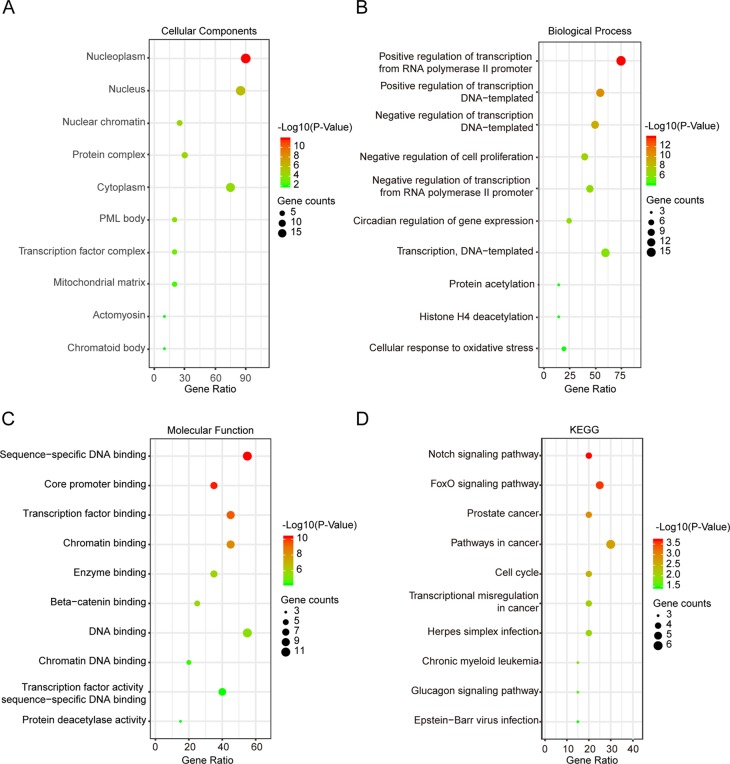
Gene Ontology (GO) enrichment and Kyoto Encyclopedia of Genes and Genomes (KEGG) pathway analysis of SIRTs and their interactors (DAVID). GO enrichment analysis of target genes based on following three aspects: (A) cellular component, (B) biological process, and (C) molecular function. (D) KEGG pathway enrichment analysis of target genes.